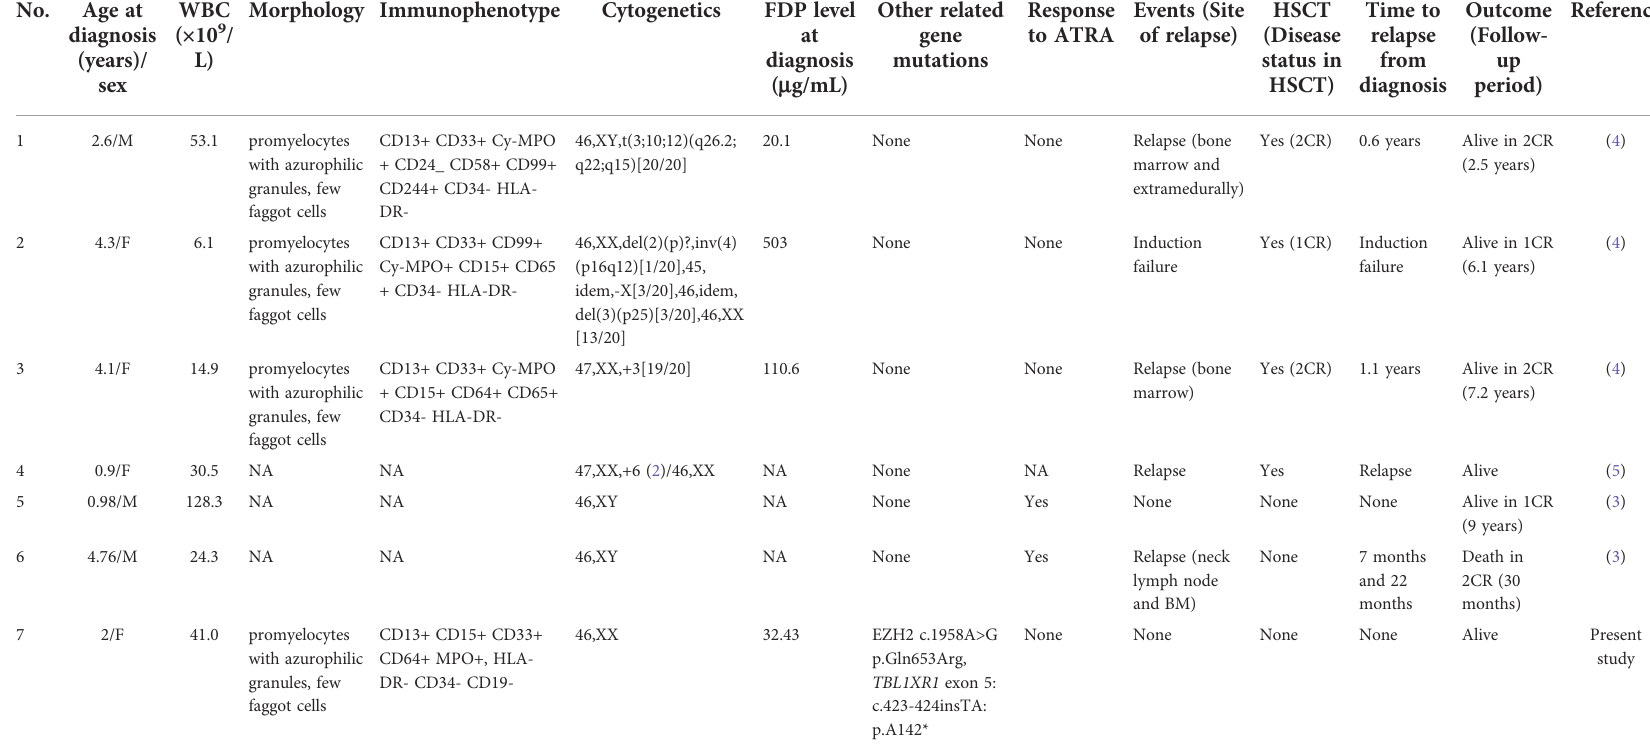
TABLE 2 variant APL with TBL1XR1-RARB fusion in literatures.